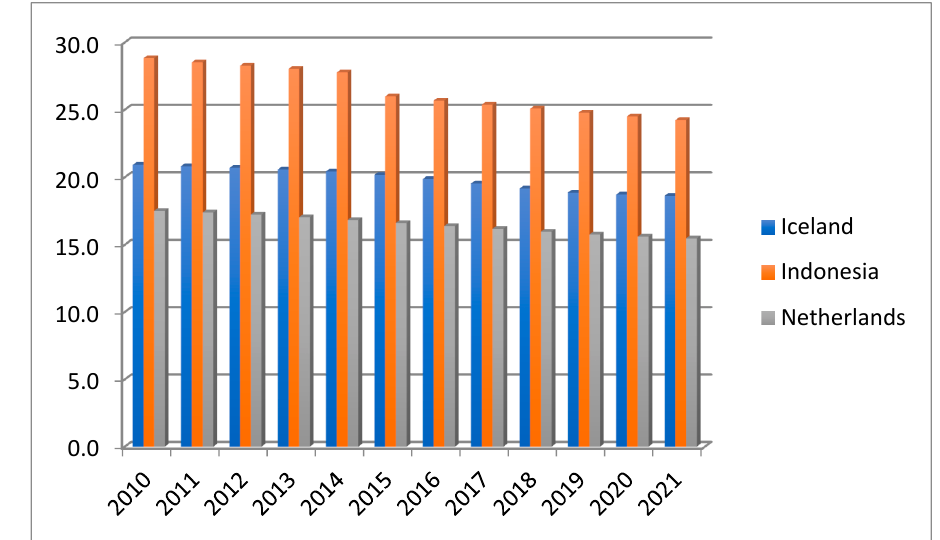
Scheme 2. Young population (people less than 15) in Iceland, the Netherlands, and Indonesia.